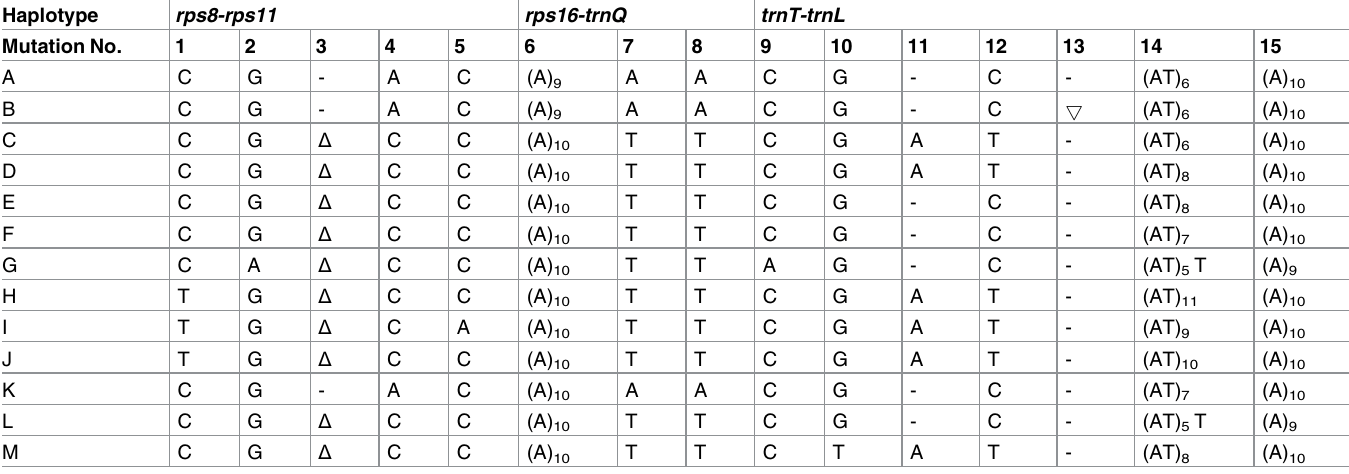
Table 2. Haplotypes of Bretschneidera sinensis based on the sequences of rps8-rps11 , trnQ-rps16 , and trnT-trnL cpDNA intergenic spacers. Haplotype